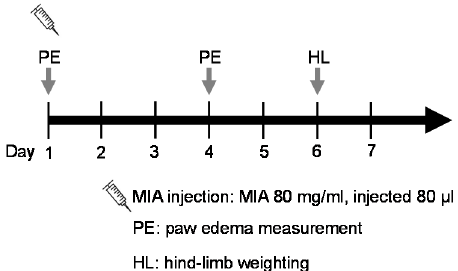
Figure 7. The experimental schedule of MIA-induced osteoarthritis model.